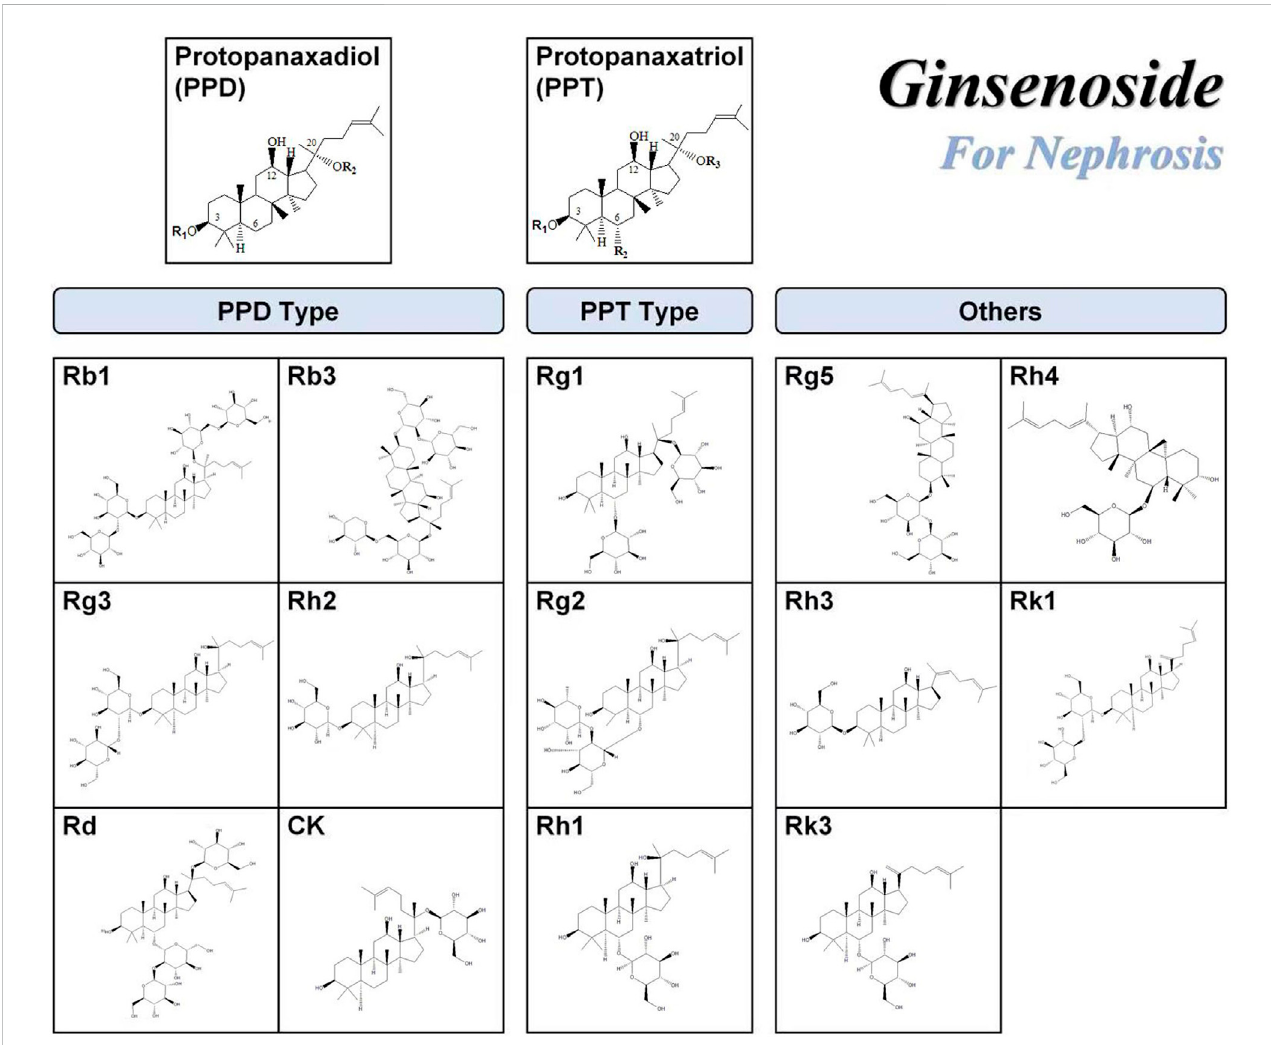
FIGURE 2 Chemical structures ofginsenosides withrenalfunctionprotection. Thechemical structures oftheginsenosides includedinthispublication weredrawn using the ChemDraw